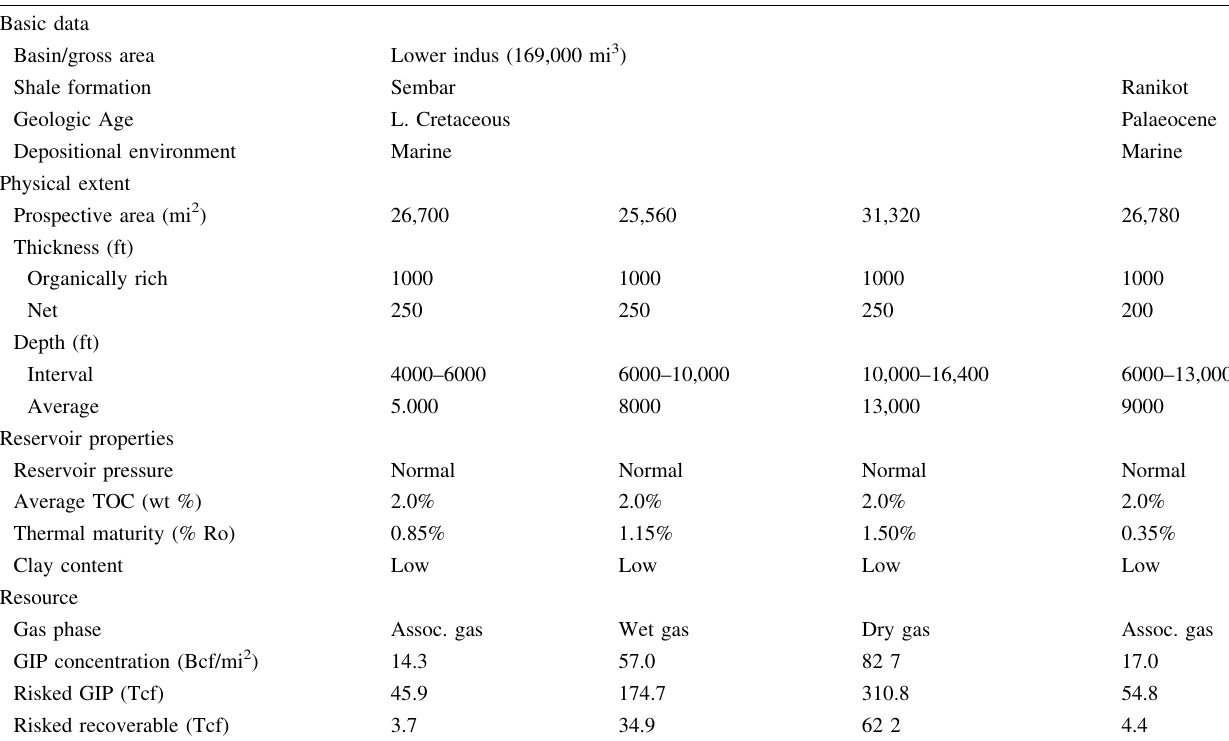
Table 2 Pakistan’s shale gas reservoir properties Source US EIA Report